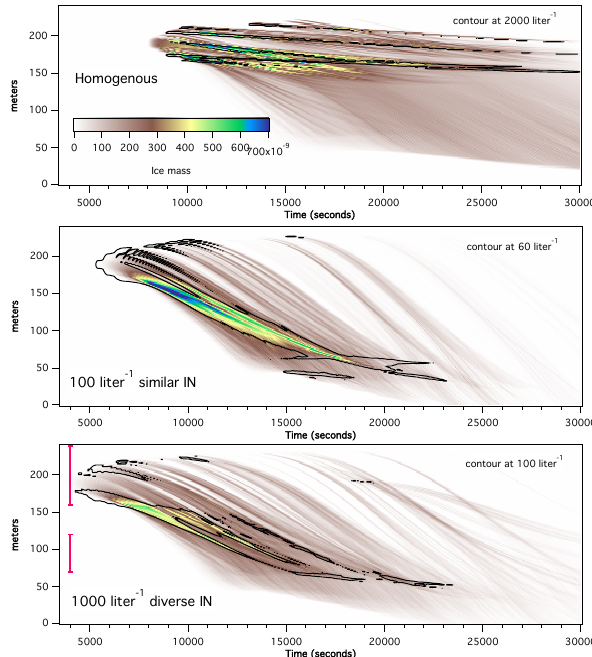
Figure 4. One-dimensional model results for three assumptions about ice nucleation and the same imposed cooling. Contours show ice crystal concentration in L − 1 . Color shows ice mass concentra- tion with the same scale for all three